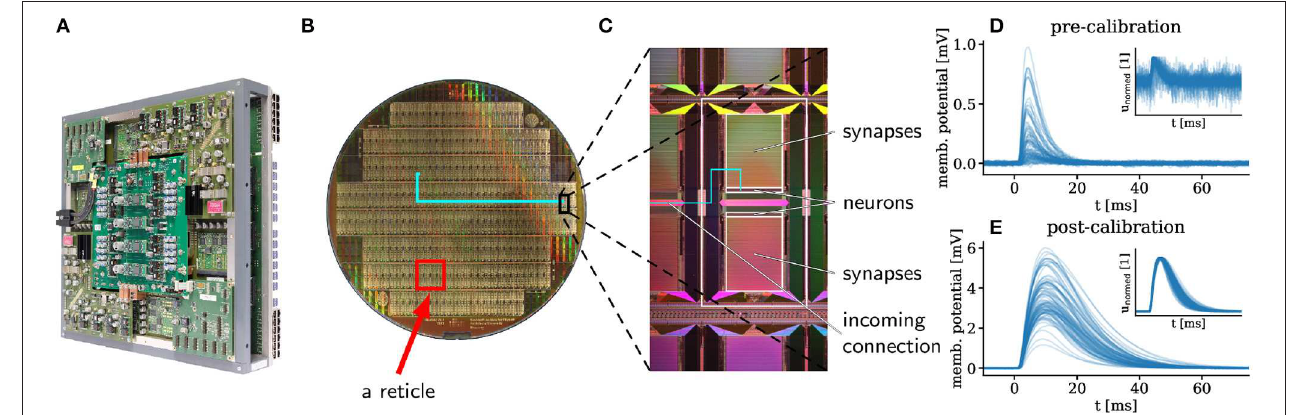
FIGURE 1 | (A) Photograph of a fully assembled wafer module of the BrainScaleS system (dimensions: 50 × 50 × 15cm). One module hosts 384 HICANN chips on 48 reticles, with 512 physical neurons per chip and 220 synapse circuits per neuron. The wafer itself lies at the center of the module and is itself not visible. 48 FPGAs are responsible for I/O and experiment control. Support PCBs provide power supply for the on-wafer circuits as well as access to neuron membrane voltages. The connectors for inter-wafer (sockets resembling USB-A) and off-wafer/host connectivity (Gigabit-Ethernet sockets) are distributed over all four edges of the main PCB. Mechanical stability is provided by an aluminum frame. (B) The wafer itself is composed of 48 reticles (e.g., red rectangle), each containing 8 HICANN chips (e.g., black rectangle, enlarged in C). Inter-reticle connectivity is added in a post-processing step. (C) On a single HICANN chip, the largest area is occupied by the two synapse matrices which instantiate connections to the neurons positioned in the neuron array. (D,E) Postsynaptic potentials (PSPs) measured on 100 different neuron membranes using the same parameter settings before (D) and after (E) calibration. The insets show the height-normalized PSPs. The calibration serves two purposes. First, it provides a translation rule between the desired neuron parameters and the technical parameters set on the hardware. In this case, it brings the time constants τ mem and τ syn close to the target of 8 ms , as evidenced by the small spread of the normalized PSPs. Second, in the absence of such a translation rule, it sets the circuits to their correct working points. Here, this happens for the synaptic weights: after calibration, PSP heights are, on average closer to the target working point of 3 mV , but they remain highly diverse due to the variability of the substrate. For more details see Schmitt et al. (2017). The PSPs are averaged over 375 presynaptic spikes and smoothed with a Savitzky-Golay filter (Savitzky and Golay, 1964) to eliminate readout noise. The time-constants are given in the biological domain, but they are 10 4 faster on the system.